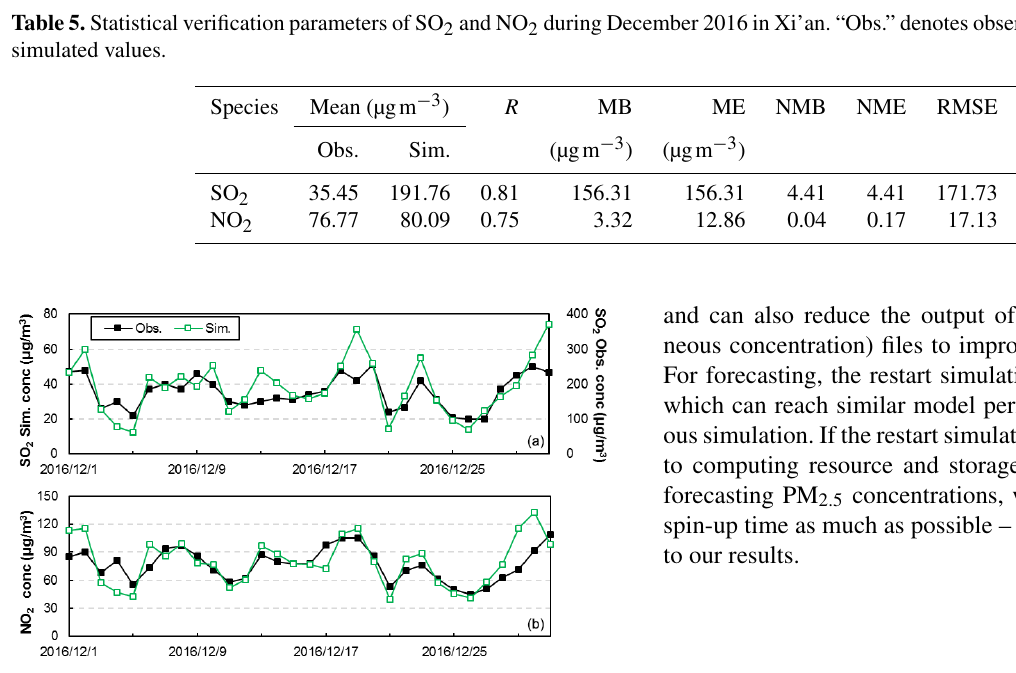
Figure 14. Time series of daily observed and simulated SO 2 (a) and NO 2 (b) concentrations averaged from 13 NSAQ observation stations during December 2016 in Xi’an. The black and green lines indicate observed and simulated results